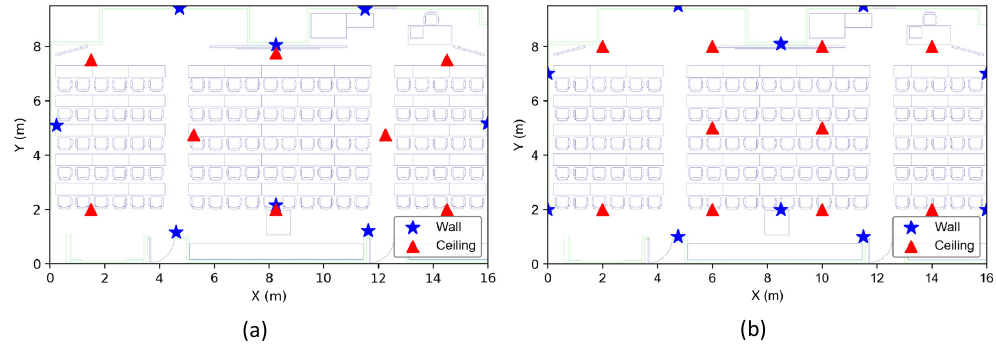
Figure 6. Deployment plans. (a) 8 iBeacons; (b) 10 iBeacons. Figure 6 . Deployment plans. (a) 8 iBeacons; (b) 10 iBeacons. Figure 6 . Deployment plans. (a) 8 iBeacons; (b) 10 iBeacons.